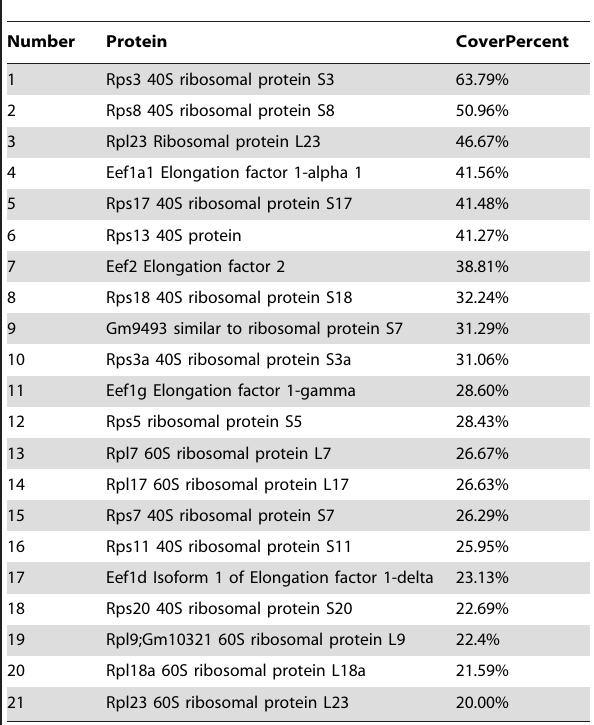
Table 1. Ribosome proteins binding to UP identified by